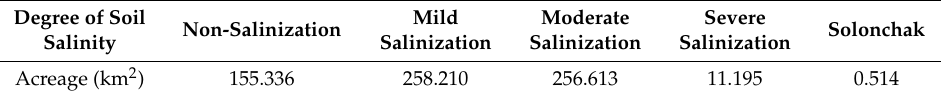
Table 5. Statistics of Salinized Soil in Shouguang City.